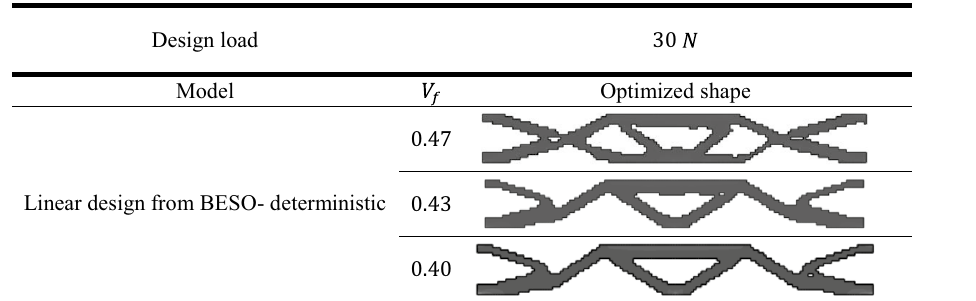
Table 1. The optimal solution of deterministic linear design of the model.